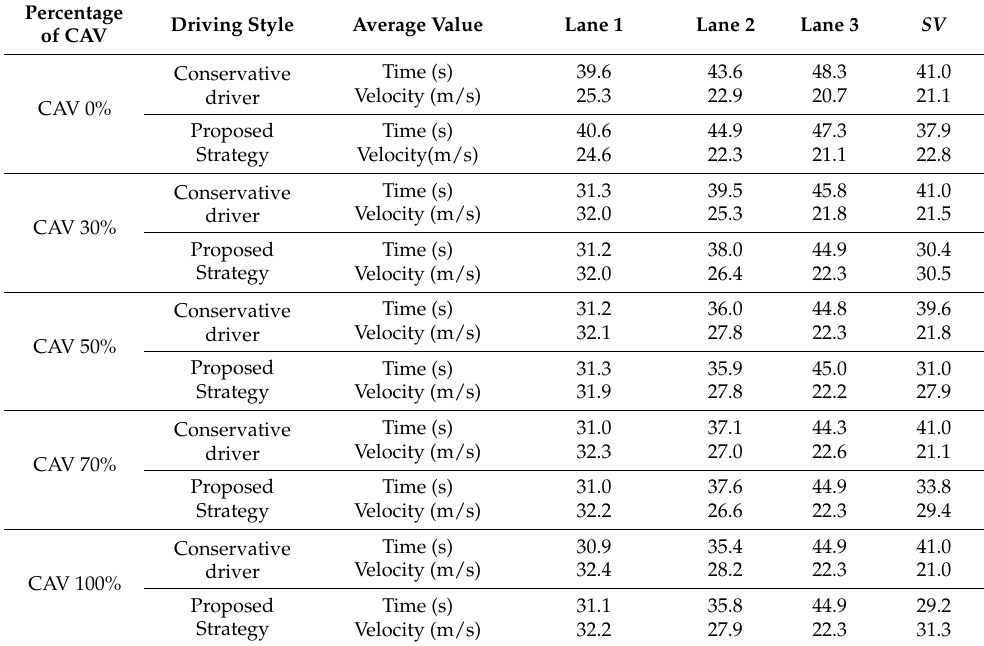
Figure 8. The velocity and acceleration of “Proposed strategy” and “Conservative driver”. Table 1. The proposed strategy performance in different CAVs proportion. Percentage of